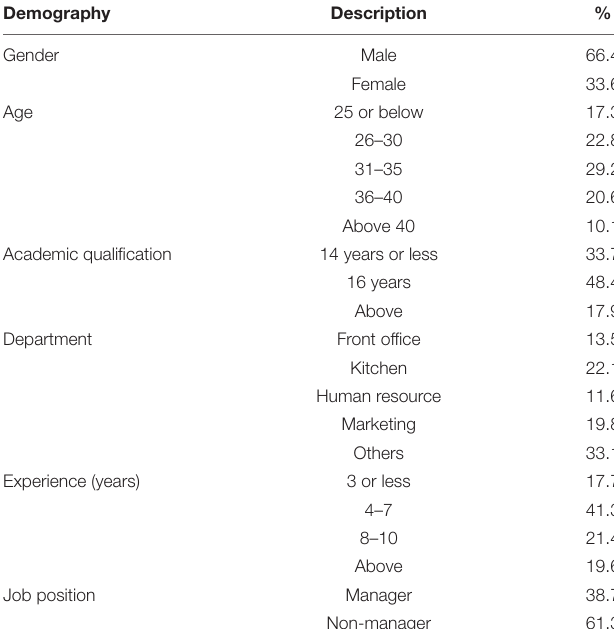
TABLE 1 | Sample profile ( N =